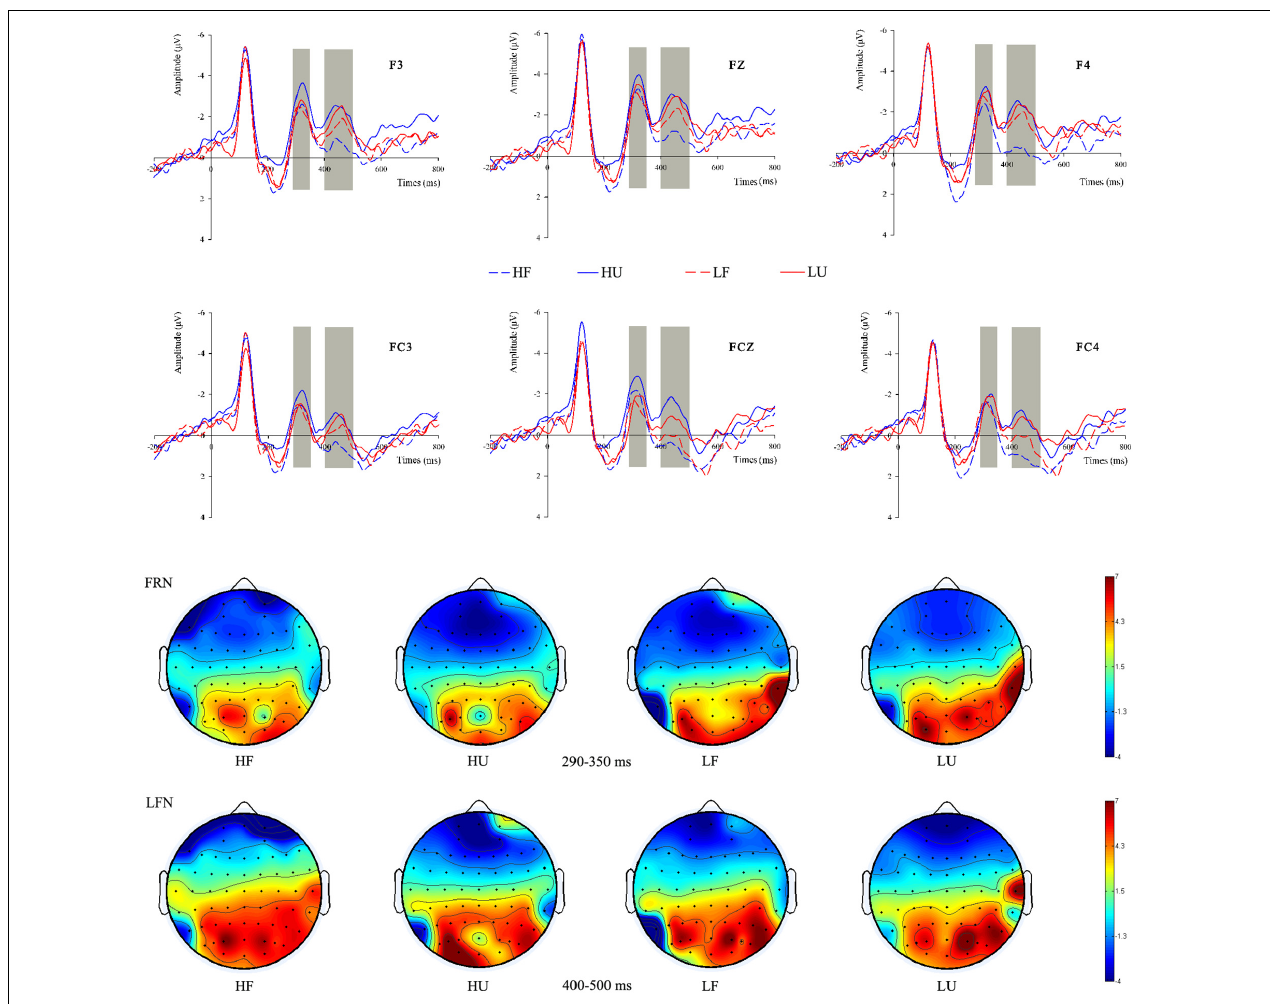
FIGURE 3 | The ERP grand-average waveforms of FRN and LFN at F3, Fz, F4, FC3, FCz, and FC4 for four conditions. The shaded 290–350 ms time window was used for the mean FRN amplitude. The shaded 400–500 ms time window was used for the mean LFN amplitude. The scalp topographic distributions of the FRN and LFN were